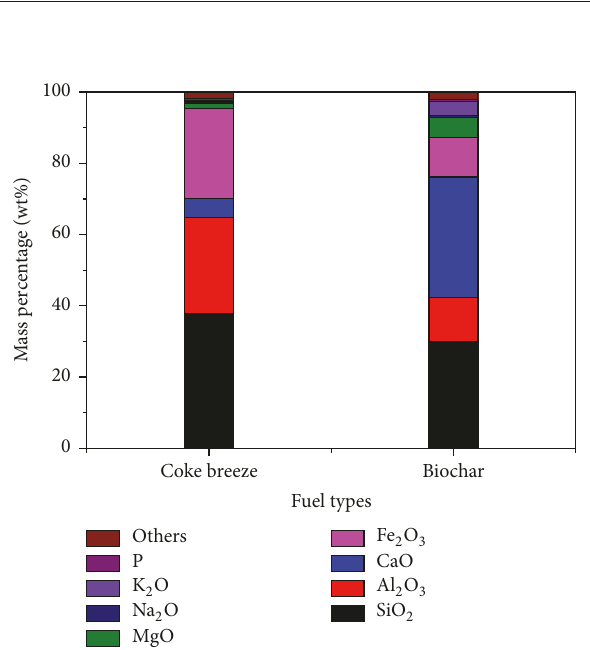
Figure 1: Chemical compositions of ash in